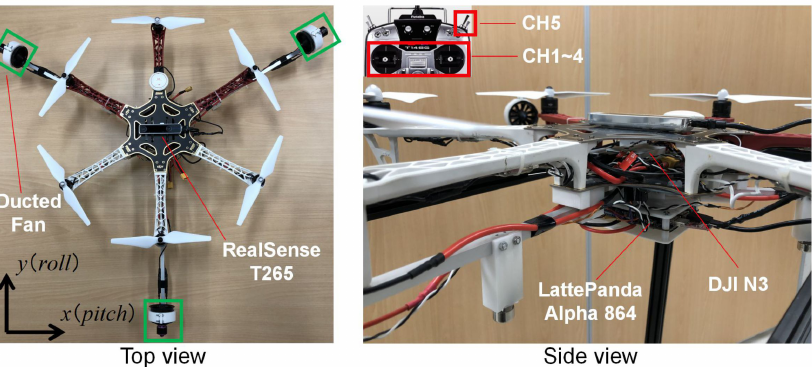
Figure 3. Pictures of ATD with multirotor system.